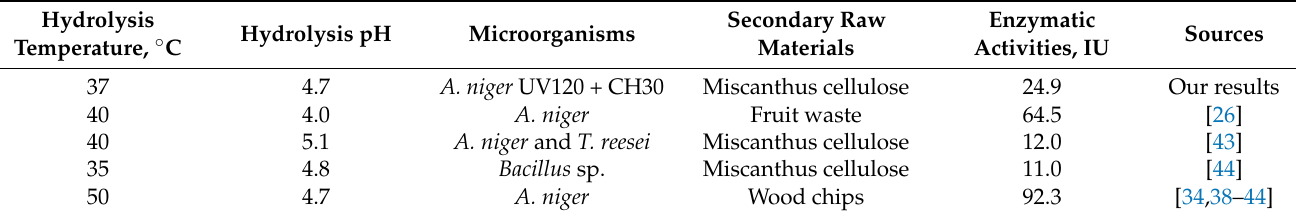
Table 8. Cellulose fermentation